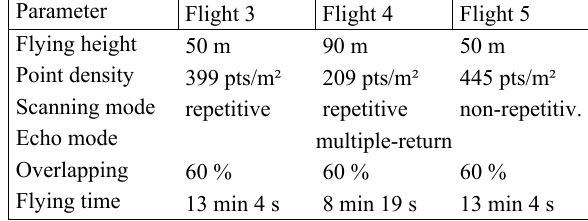
Table 2 . Aerial flights with the Zenmuse L1 laser